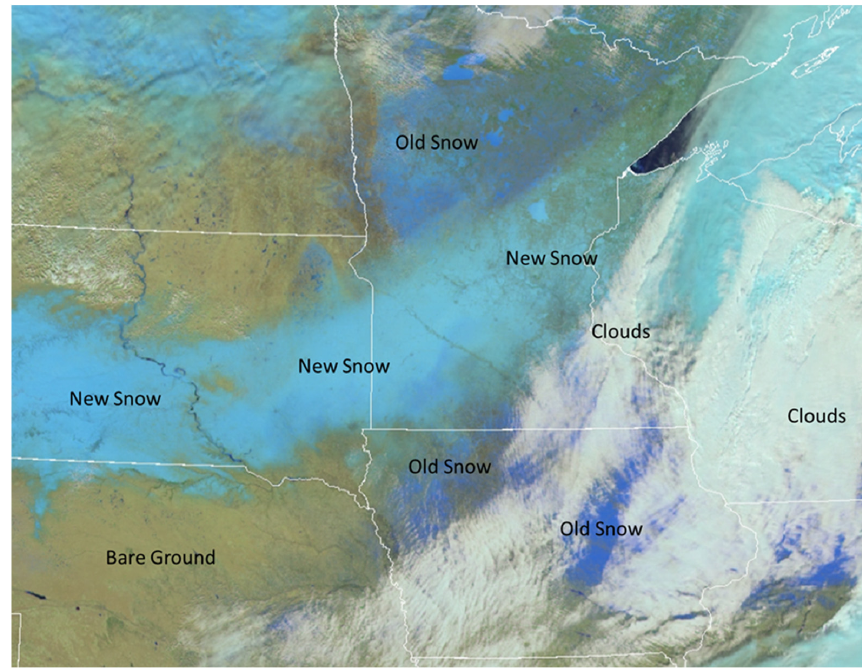
Figure 8. New Snowmelt RGB (28 February 2021) generated at CIRA differentiates newer snowfall from older/melting snowfall after recent Midwest snow events. See https://satelliteliaisonblog.com/2021/03/04/viirs-and-abi-capture-ice-vs-snow-and-melting-snow/ accessed on 4 April 2022.